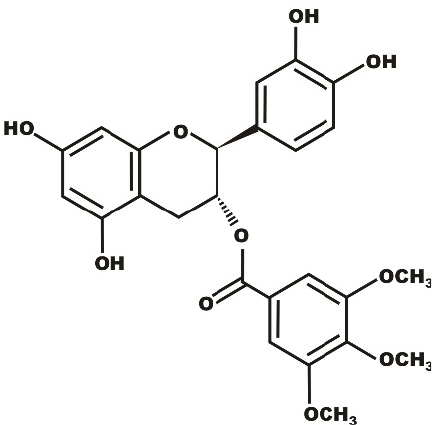
Figure 1. Chemical structure of TMBC.